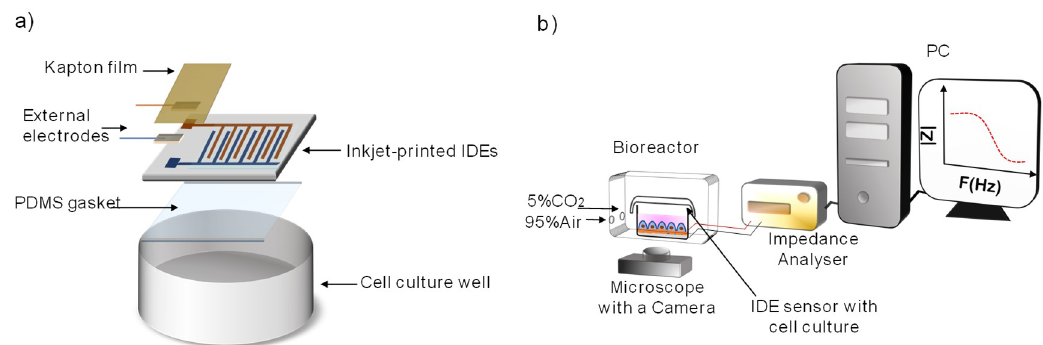
Figure 2. ( a ) Assembly and packaging of the IDE-based devices to perform impedance spectroscopy of cultured cells. ( b ) Schematic representation of the impedance-based biosensor system. The system consists of inkjet-printed IDE sensors, an IDEs-based chamber, an impedance analyzer, a microscope with an integrated bioreactor and a PC to control the images ‘acquisition and the impedance recordings in real-time.